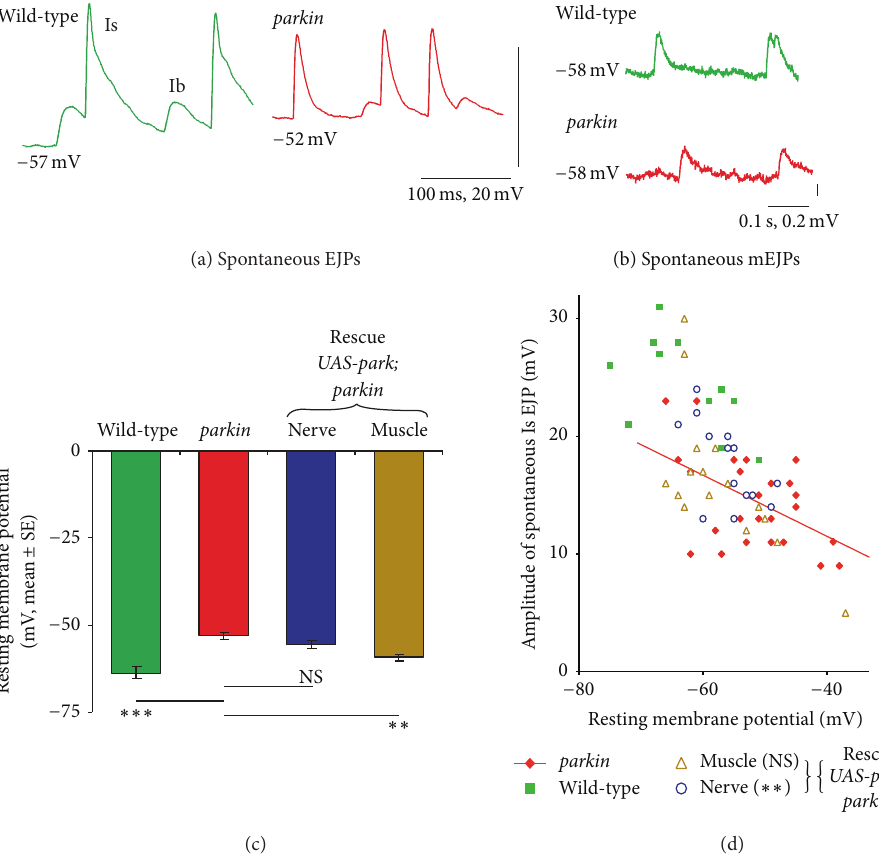
Figure 3: Parkin mutants display depolarisation of the muscle resting membrane potential coupled with reduced EJP amplitudes. (a) Spontaneous excitatory junction potentials (EJPs) were recorded from muscle 6 or 7. The mean resting potential and amplitude of the EJPs in the parkin mutant ( park Z3678 / parkin 25 ) were ∼ 12mV more positive than in wild-type ( CS/w 1118 ). In this recording both the Is and Ib EJPs are visible: both were reduced in the parkin mutant. (b) The spontaneous miniature EJPs (mEJPs) are smaller in the parkin mutant, as shown by these two recordings made at the same RMP. (c) Quantification of the change in resting membrane potential (RMP) in the parkin mutant, and the rescue by expression of Drosophila wild-type parkin in the muscle ( G14 GAL4), but not the nerve ( elav 3e1 GAL4). (d) The plot of the size of Is EJP as a function of RMP shows that the more negative the RMP, the larger the EJP. However, at any chosen RMP, the wild-type EJP is bigger than those recorded from the parkin mutant. Note that all the green data points lie above the red regression line plotted through the parkin data. Expressing parkin in the nerves leads to data points that significantly lie above the red regression line, 𝜒 2 1 showing effective rescue of the phenotype. parkin expression in the muscle leads to data distributed symmetrically about the regression line, no rescue. Data from [23] with (d) showing some data